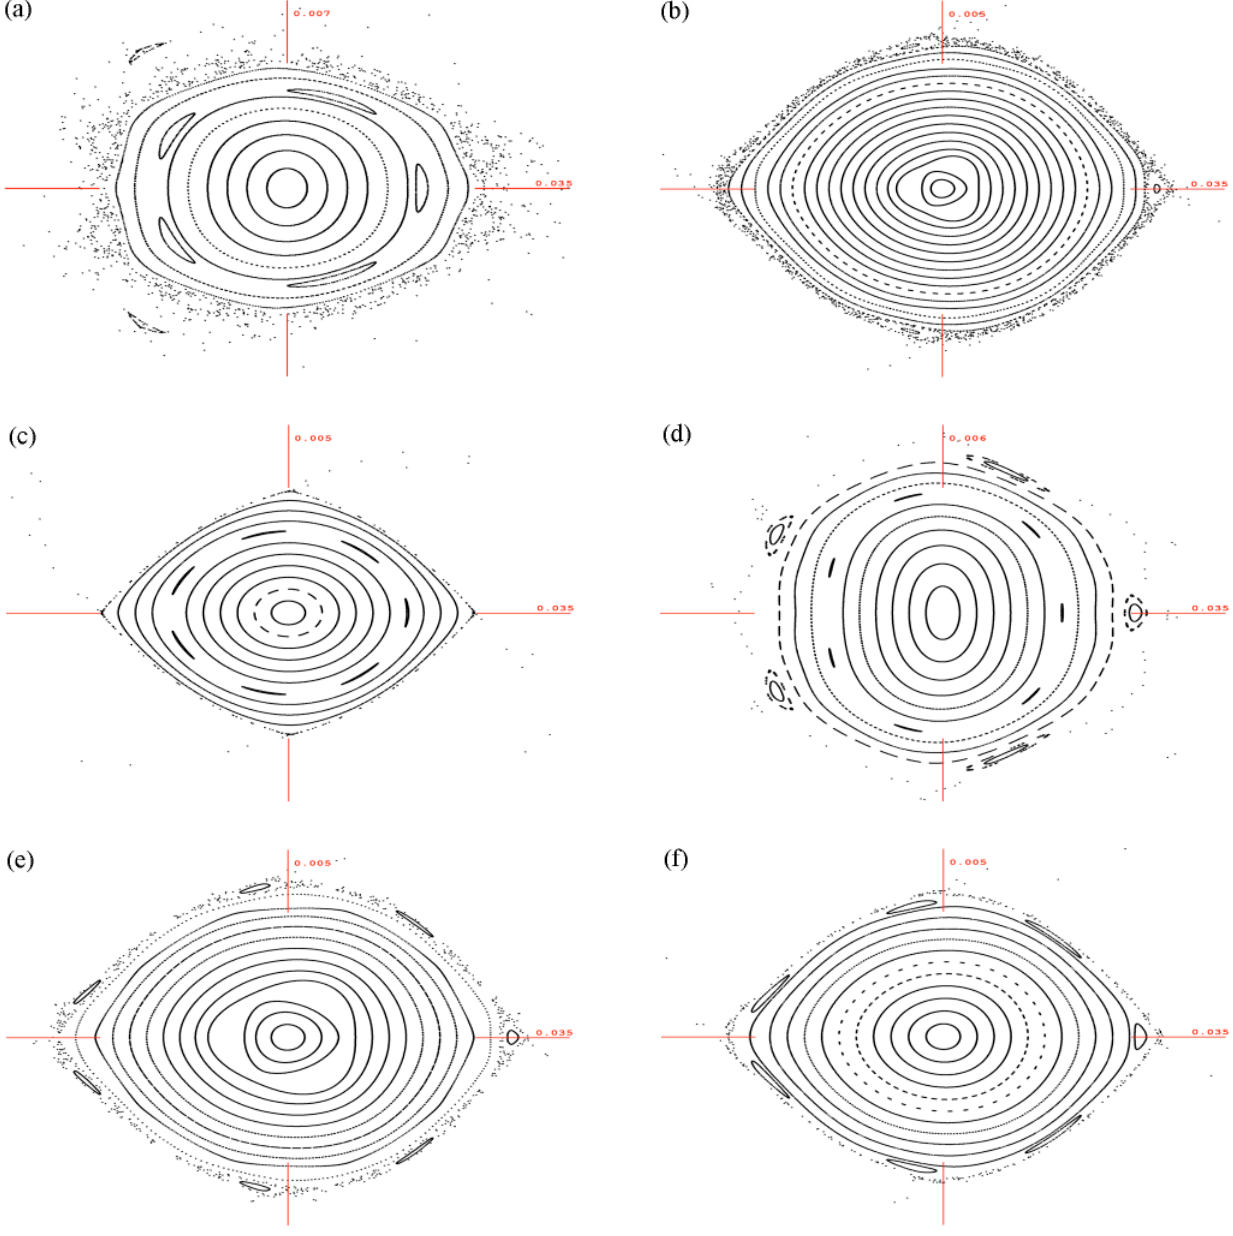
FIG. 11. (Color) Tracking pictures of on-energy particles launched along the x axis with vanishing transversal momenta, magnet aperture of 75 mm, for all six types of fringe fields. The following fringe field types are depicted: (a) default dipole, (b) default quadrupole, (c) default sextupole, (d) LHCHGQ lead end, (e) two parameter Enge function, and (f) GSI QD